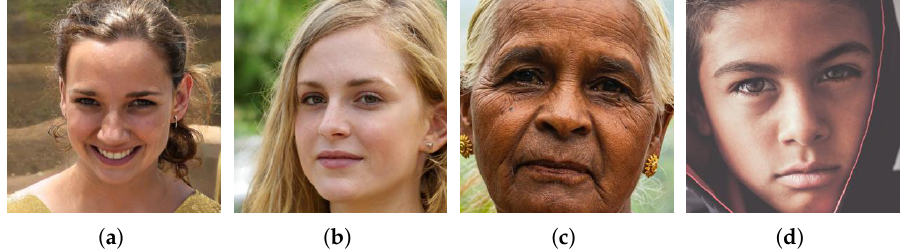
Figure 1. Sample images extracted from the dataset. Note that ( a , b ) are fake image, whereas ( c , d ) rep- resent real